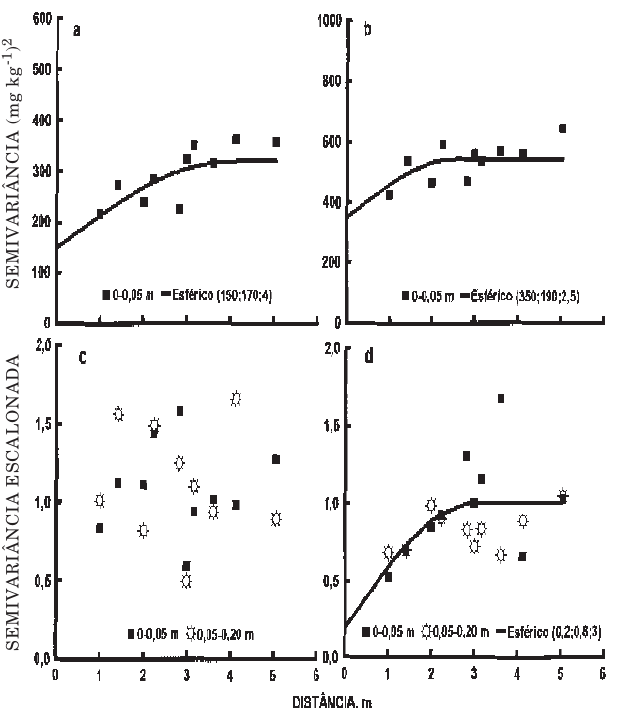
Figura 1. Semivariogramas para fósforo no solo nas áreas amostradas em Eldorado do Sul (RS), para (a) preparo convencional, (b) plantio direto, (c) escarificação e (d) pastagem. As legendas dos gráficos incluem o modelo ajustado aos dados e, entre parênteses, os coeficientes C 0 , C 1 e alcance da dependência espacial; C 0 + C 1 representam o patamar do semivariograma.